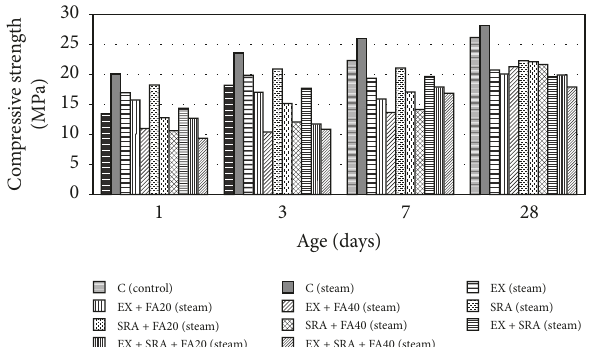
Figure 5: Compressive strength of steam-cured mortar.